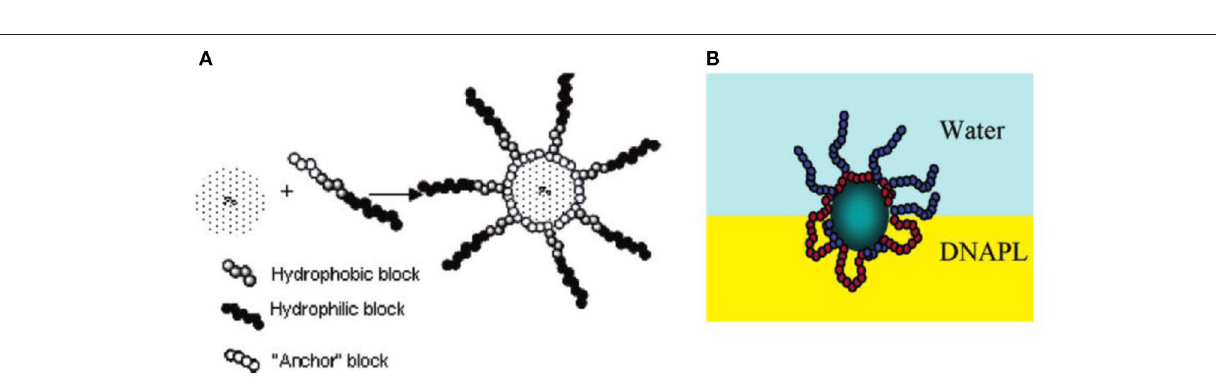
(PEG) endows Fe 3 O 4 nanoparticles with superior